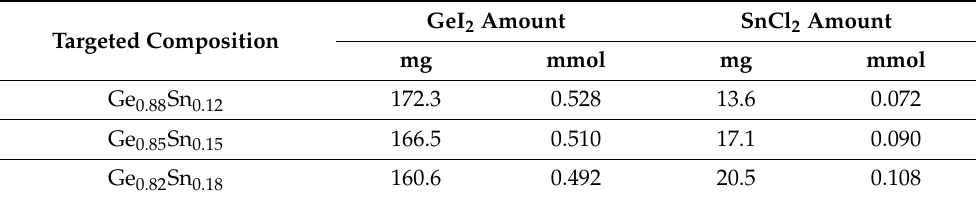
Table 1. Amounts of GeI 2 and SnCl 2 for the synthesis of Ge 1 − x Sn x